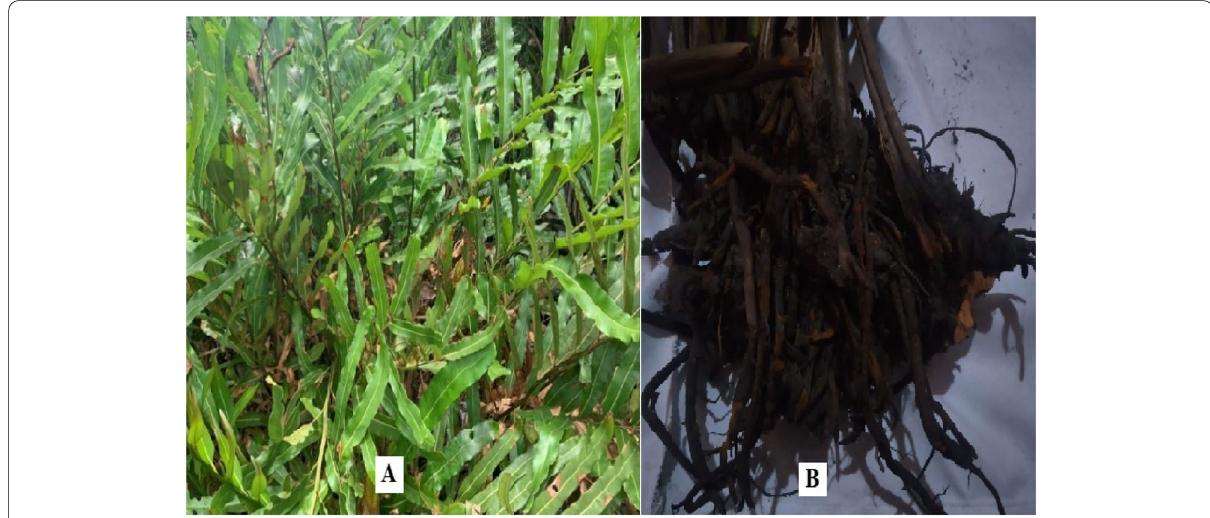
Fig. 1 Leaves ( A ) and Roots ( B ) of Acrostichum